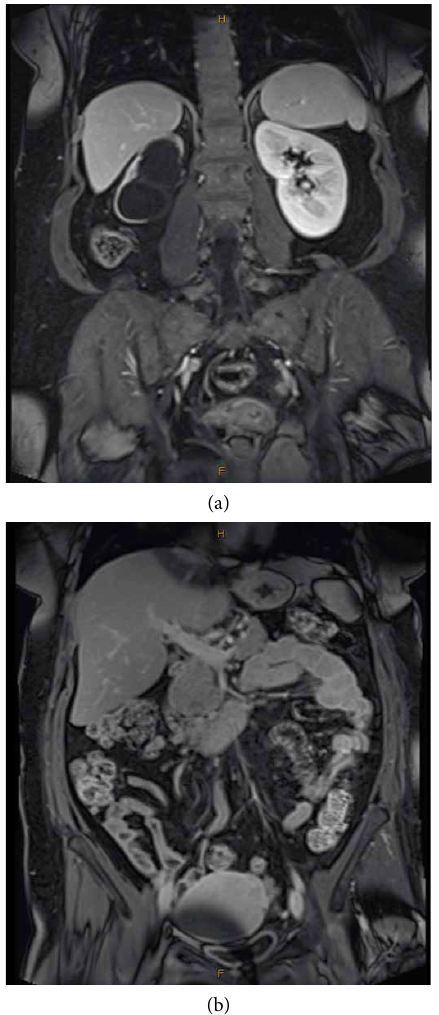
Figure 6: MRI confirmed significant right hydronephrosis with marked thinning of the renal parenchyma (a), and right hydroureter